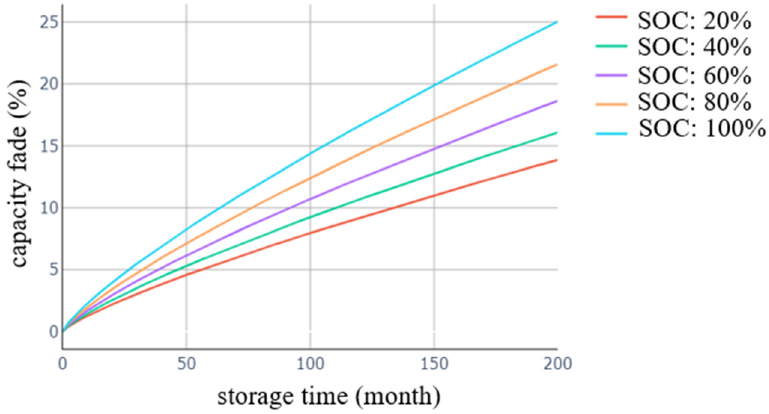
Figure 5. Calendar aging curves.